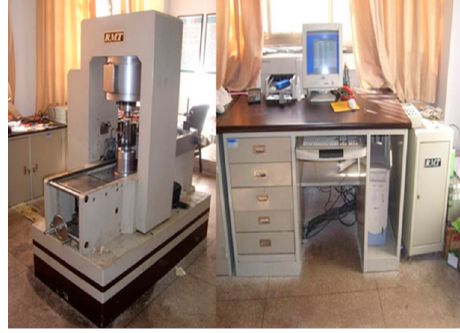
Figure 3. RMT-150B servo-control testing machine.